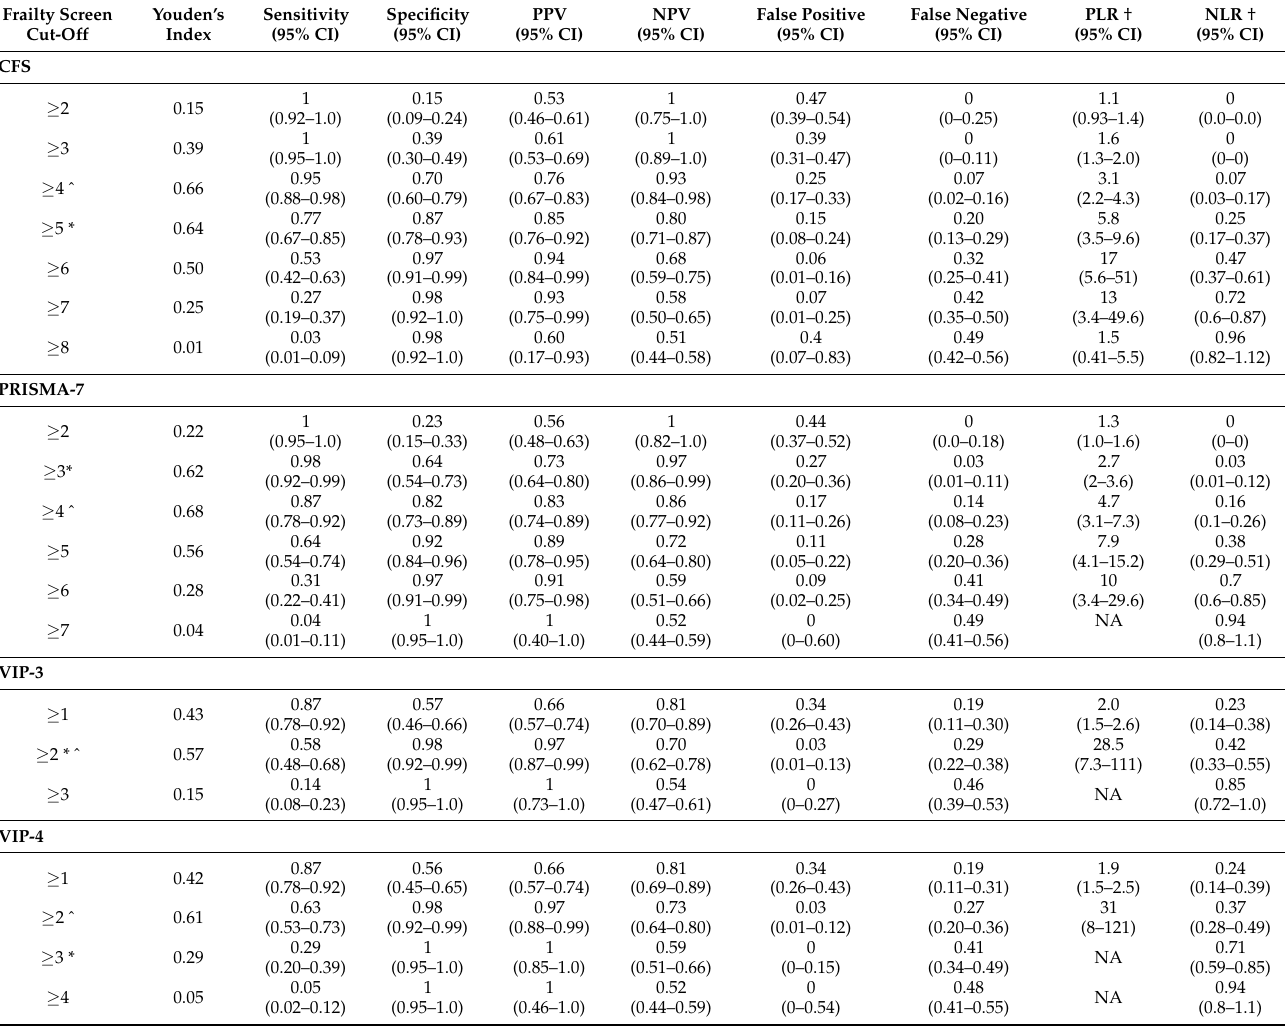
Table 3. Sensitivity, specificity, positive predictive value (PPV), negative predictive value (NPV), positive (PLR) and negative likelihood ratio (NLR) with 95% confidence intervals (CI), for the Clinical Frailty Scale (CFS), PRISMA-7 and the three and four-item versions of the Variable Indicative of Placement risk (VIP) in their ability to differentiate frail from non-frail based on an independent comprehensive geriatric